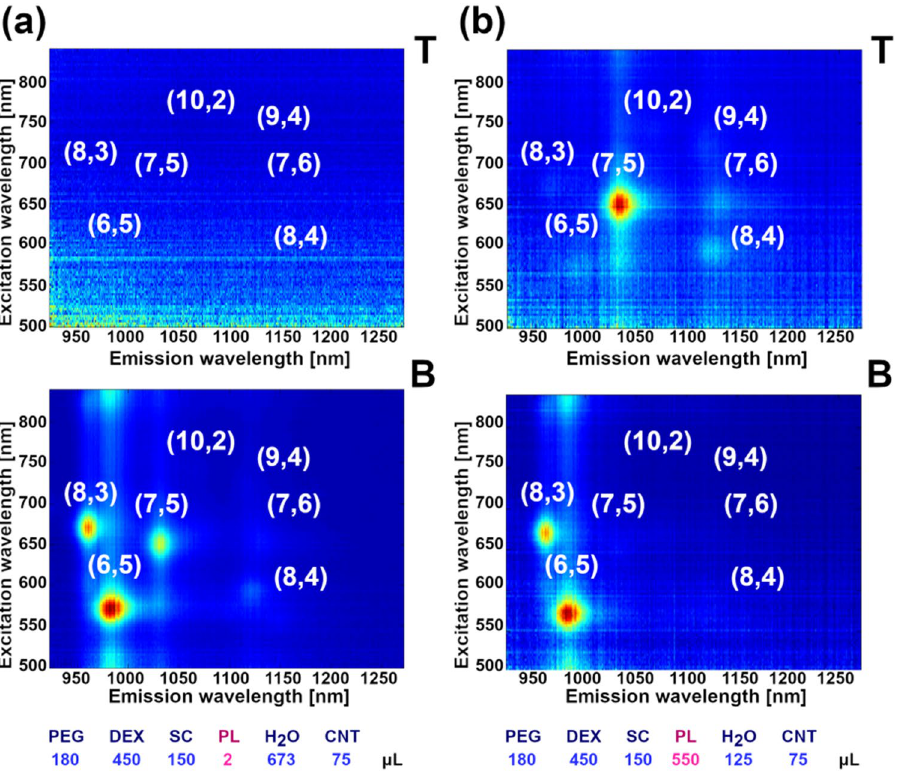
Figure 3. 2D PLE maps of SC-dispersed, (6,5)-enriched SWCNTs sorted by ATPE upon varying the added volume of Pluronic. Example volumes: ( a ) 2 µL, and ( b ) 550 µL of PL. 2D PLE maps of remaining samples are shown in Supplementary Animation 3. Analogous data for unsorted SWCNT material is presented in Fig. S4 and Supplementary Animation